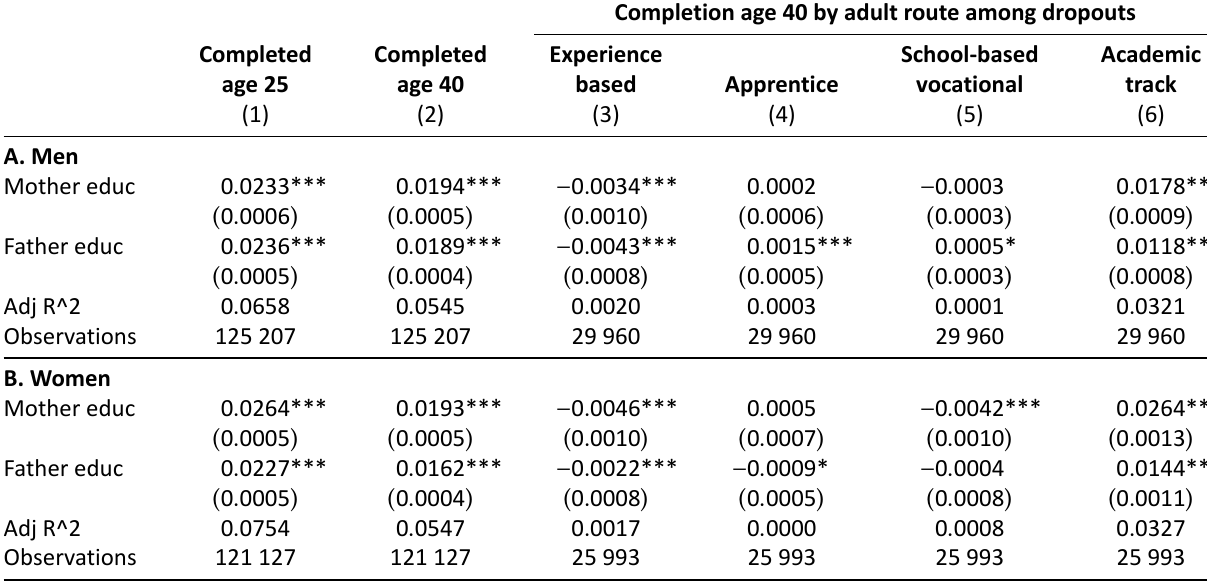
Table 4. Completion of upper secondary education: mother’s vs. father’s years of